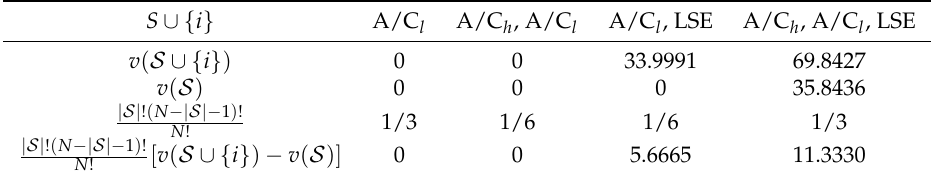
Table 7. Reward of A/C l .